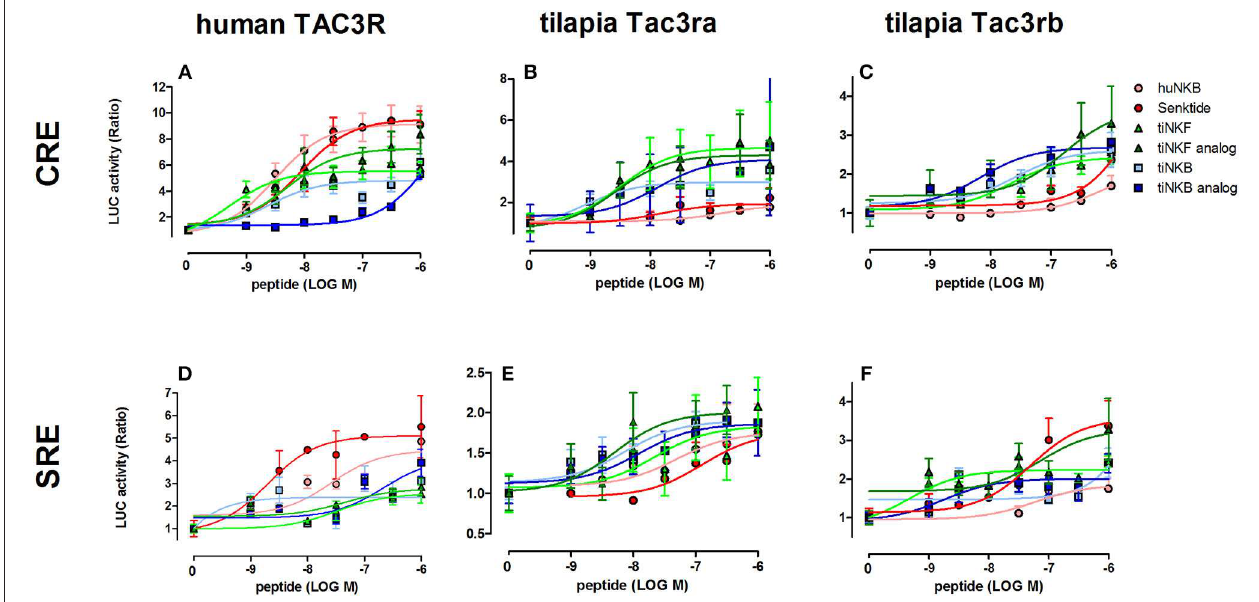
FIGURE 2 | Tilapia NKB peptides and analogs induced transcriptional activity in CRE- and SRE-Luciferase reporters. COS-7 cells were co-transfected with human TAC3R (A,D) , tilapia (ti) Tac3ra (B,E) , and tilapia Tac3rb (C,F) together with a reporter plasmid. Cells were treated with various concentrations of human and tilapia NKB peptides and their analogs. The data are expressed as the change in luciferase activity over basal and are from a single experiment representative of a total of 3 such experiments. Each point was determined in triplicate and is shown as a mean ± SEM.